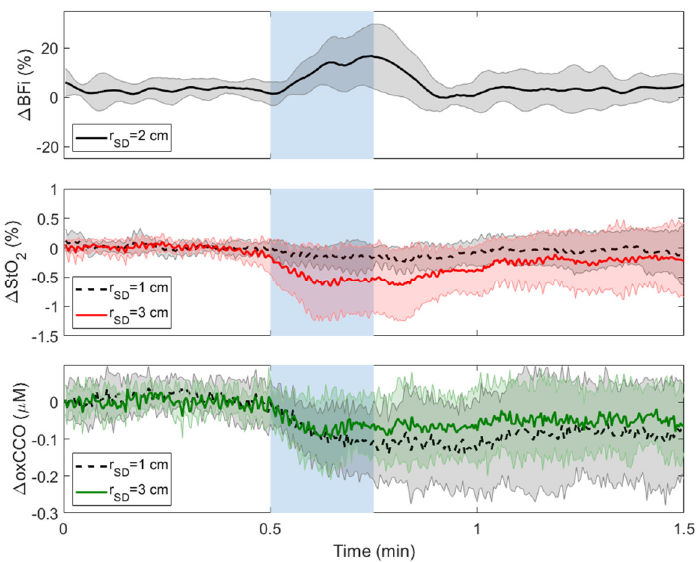
Figure 6. Average temporal change in BFi in response to contralateral 15-s CC, indicated by the blue region. Time courses were averaged across subjects, and shading surrounding each line represents the standard deviation.